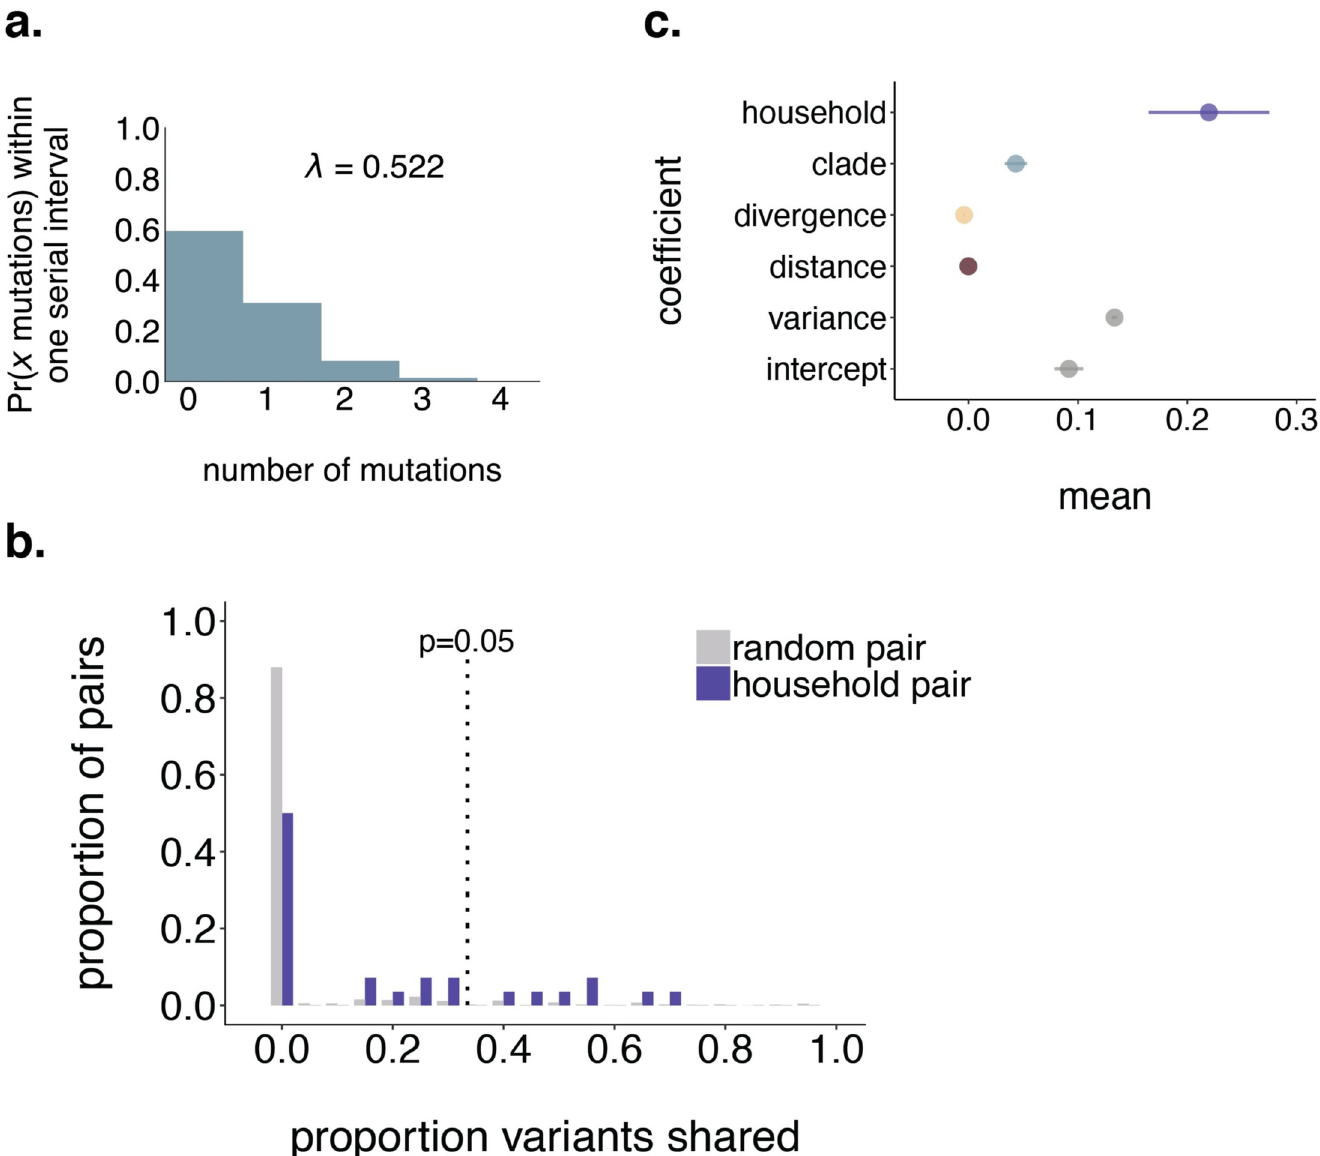
Fig 4. A quarter of household pairs share more iSNVs than random expected by chance. a. We modeled the probability that 2 consensus genomes will share x mutations as Poisson-distributed with lambda equal to the number of mutations expected to accumulate in the SARS-CoV-2 genome over 5.8 days [37] given a substitution rate of 1.10 x 10 − 3 substitutions per site per year [1]. Exploration of how these probabilities change using a range of plausible serial intervals and substitution rates is shown in S8 Fig. The vast majority of genomes that are separated by one serial interval are expected to differ by � 2 consensus mutations. b. The proportion of random pairs (grey) and putative household transmission pairs (purple) is shown on the y-axis vs. the proportion of iSNVs shared. The dotted line indicates the 95th percentile among the random pairs. Household pairs that share a greater proportion of iSNVs than 95% of random pairs (i.e., are plotted to the right of the dotted line) are considered statistically significant at p = 0.05. iSNVs had to be present at a frequency of � 3% to be considered in this analysis. c. We assessed the impact of household membership, clade membership, phylogenetic divergence, and geographic distance on the proportion of iSNVs shared between each pair of samples in our dataset. The mean of each estimated coefficient in the combined linear regression model including all predictors is shown on the x-axis, with lines of spread indicating the range of the estimated 95% highest posterior density interval (HPDI).